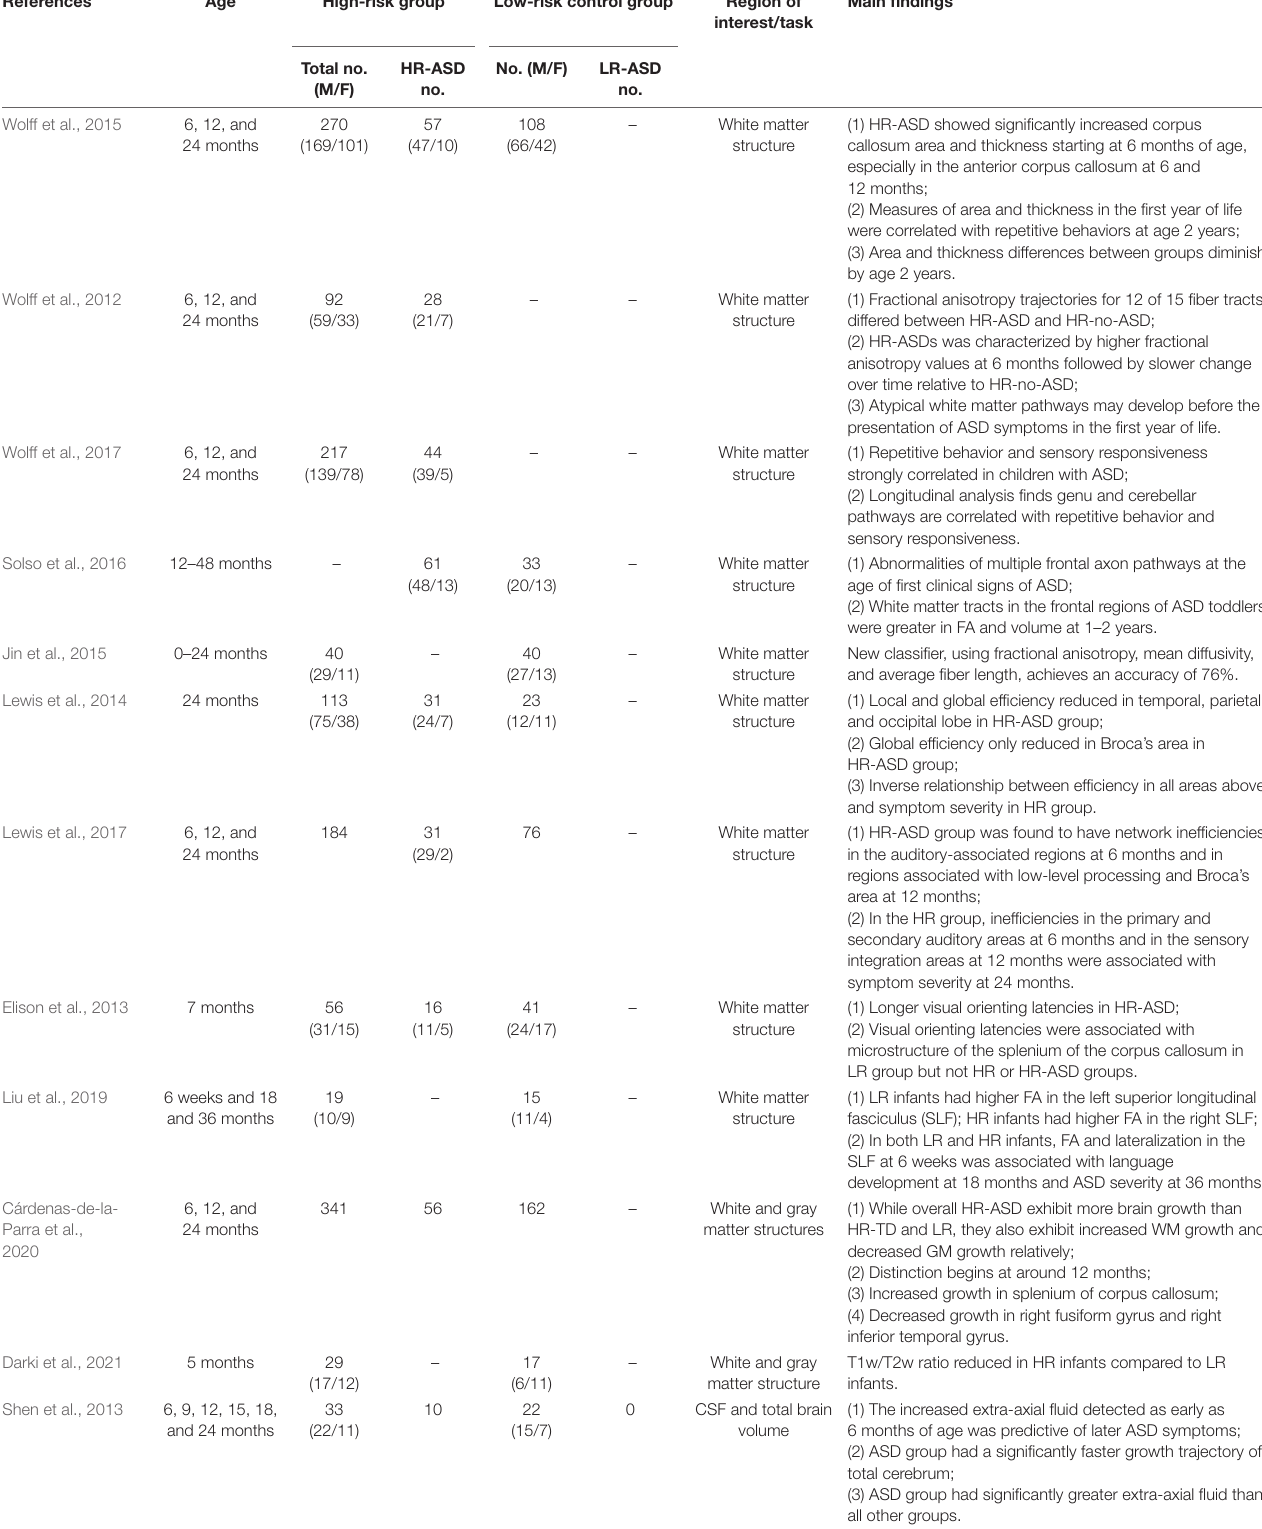
TABLE 1 | Magnetic resonance imaging (MRI) studies on early screening of autism spectrum